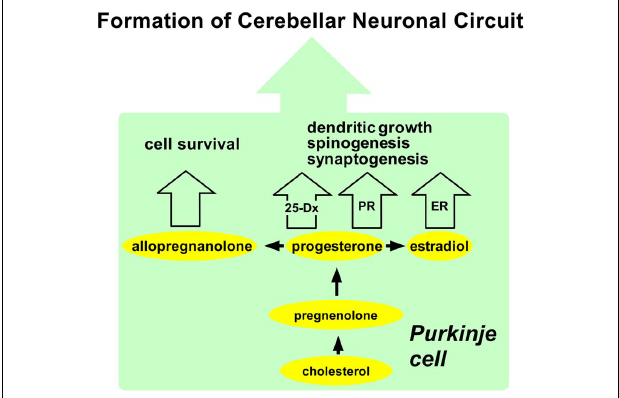
FIGURE 4 | Summary of possible actions of neurosteroids in the Purkinje cell during development. The Purkinje cell actively synthesizes progesterone, allopregnanolone, and estradiol from cholesterol during neonatal life when cerebellar neuronal circuit formation occurs in mammals. Progesterone acts on the Purkinje cell through intranuclear receptor (PR)-mediated mechanisms that promote dendritic growth, spinogenesis, and synaptogenesis in this neuron by genomic mechanisms. Progesterone may also promote dendritic growth, spinogenesis, and synaptogenesis via 25-Dx as well as its nuclear receptor in the Purkinje cell in the neonate. Estradiol acts on the Purkinje cell through intranuclear receptor (ER)-mediated mechanisms that promote dendritic growth, spinogenesis, and synaptogenesis in this neuron by genomic mechanisms. Allopregnanolone is involved in Purkinje cell survival. See the text for details. PR, progesterone receptor; ER, estrogen